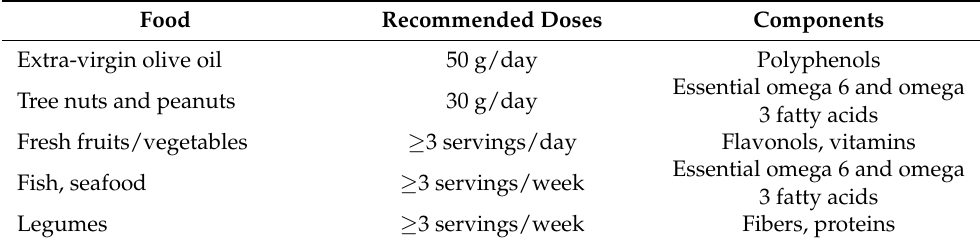
Table 1. The main beneficial components in the Mediterranean